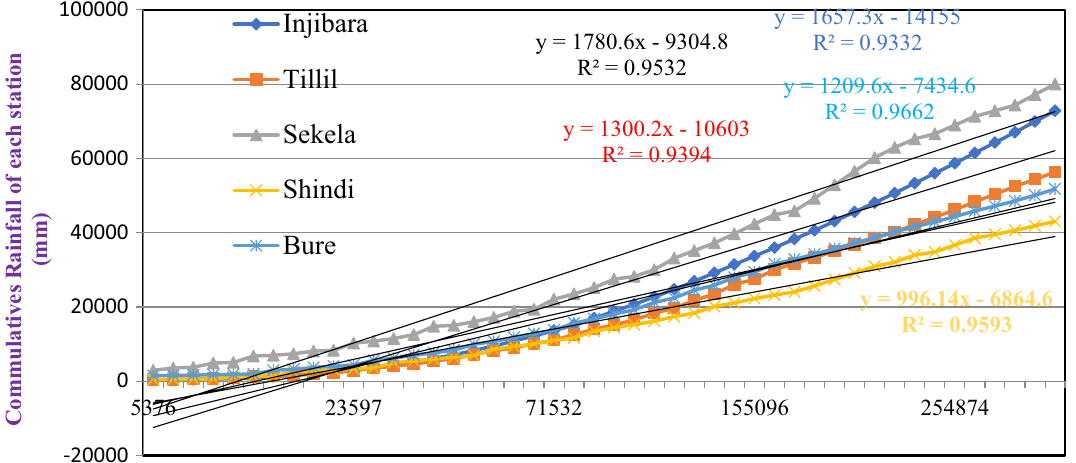
Hydrological component of SWAT To simulate the hydrology of a watershed, two distinct divisions were used. The first was a land stage of the